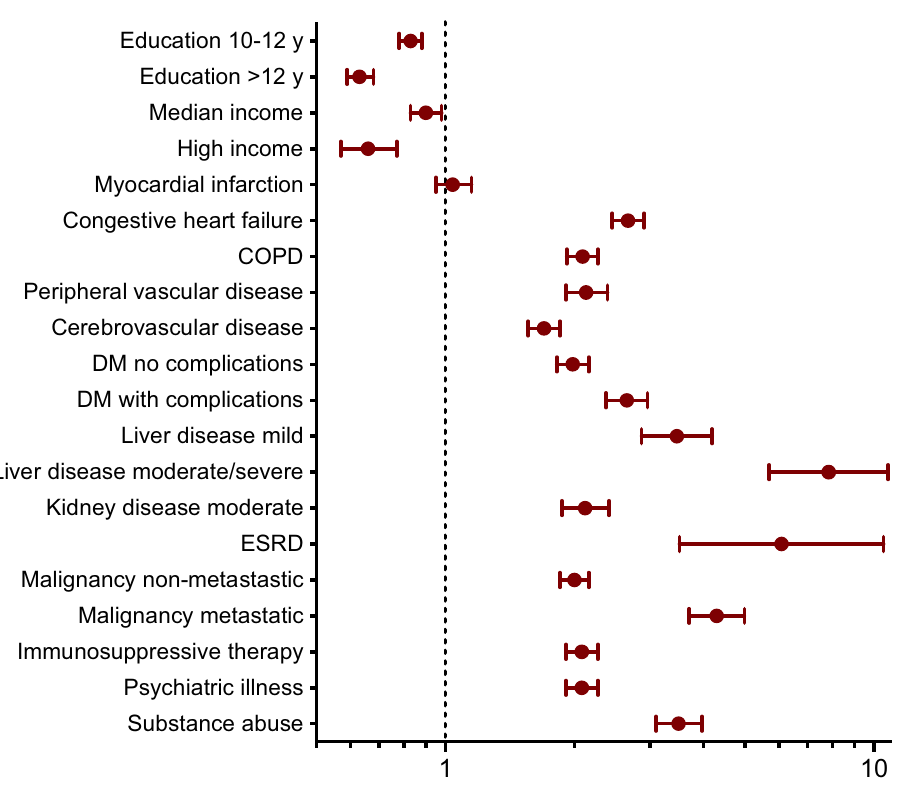
Figure 1. Multivariable logistic regression analysis of risk factors for community-acquired sepsis. Logarithmic scale for odds ratios with 95% confidence intervals on the x-axis. COPD Chronic obstructive pulmonary disease, DM Diabetes mellitus, ESRD End-stage renal disease.